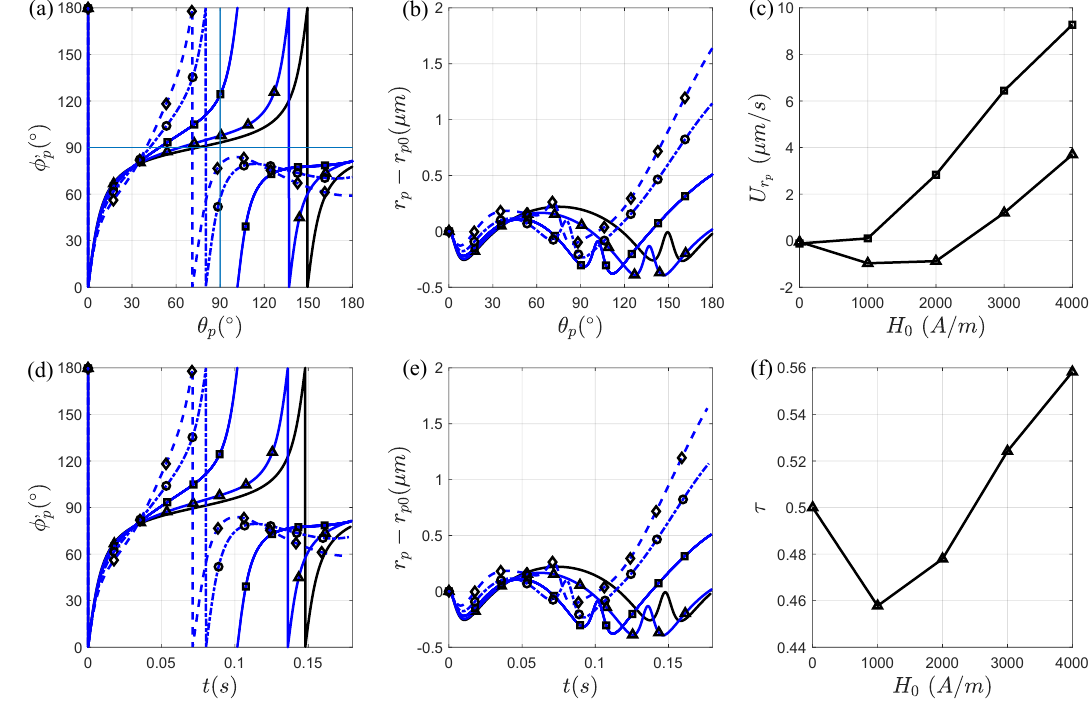
Figure 5. Effect of the magnetic field strength when it is applied at α = 90 ◦ . The particle ( AR = 4) is affected by the magnetic field when its center of mass is approximately at θ p = 0 ◦ in ( a , d ) when its rotation is with respect to θ p and time, respectively, for, H 0 = 0 A/m (solid black line), H 0 = 1000 A/m (triangle symbol), H 0 = 2000 A/m (square symbol), H 0 = 3000 A/m (circular symbol), H 0 = 4000 A/m (diamond symbol). The radial particle-wall distance change of the particle with respect to ( b ) θ p , and ( e ) time. ( c ) The radial velocities of the particle U rp (triangle symbol) and U r θ (square symbol) as functions of H 0 . ( f ) The dimensionless parameter τ as a function of H 0 . We see that as τ increases, the net migration of the particle